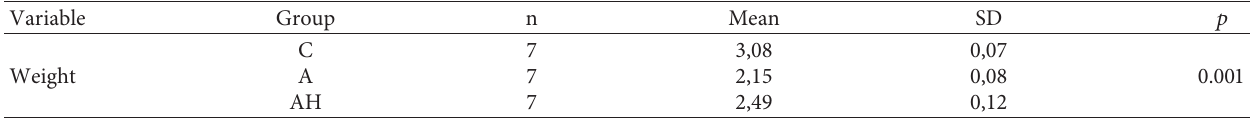
Figure 1: Clinical picture of control, AMAN, and AMAN rabbits treated by HBO. (a) Median Tarlov score of “5” at control group. (b) Median Tarlov score of “3” at AMAN group. (c) Median Tarlov score of “4” at AMAN with HBO group. Table 2: Descriptive data of body weight of the rabbit model.